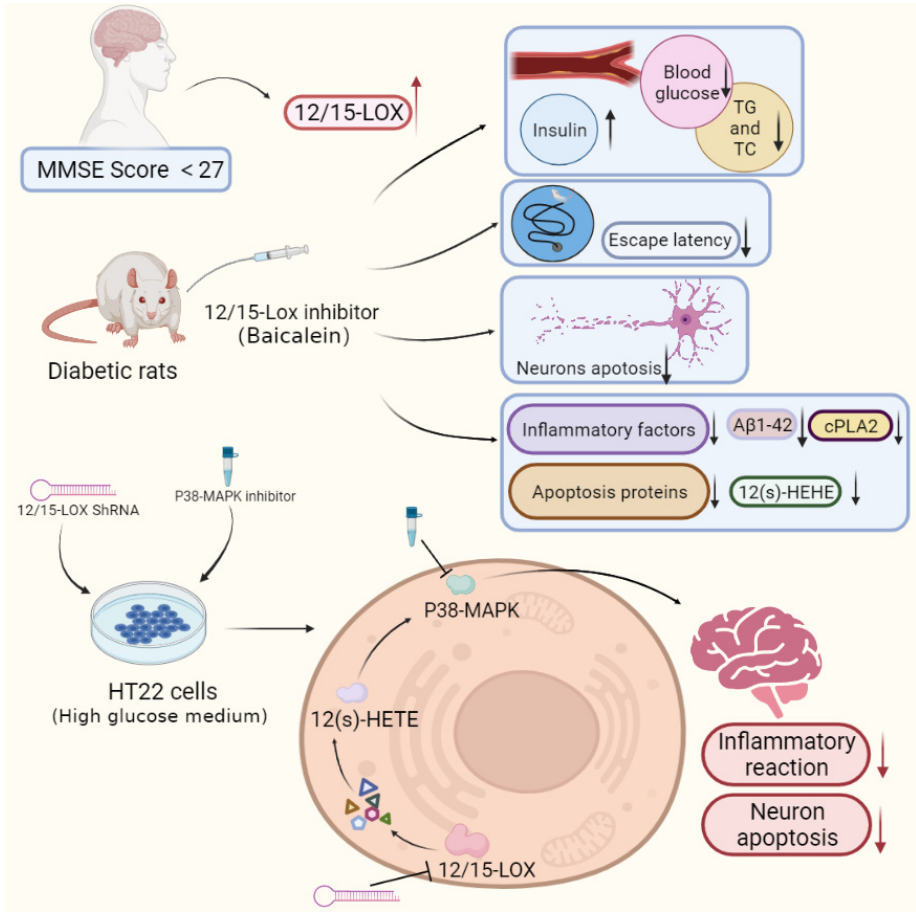
Figure 6. Activation of 12/15-LOX leads to diabetic cognitive dysfunction by increasing the inflam- matory response in the hippocampus. 12/15-LOX regulates p38 MAPK to mediate the inflammatory response and apoptosis which aggravate diabetic cognitive dysfunction.